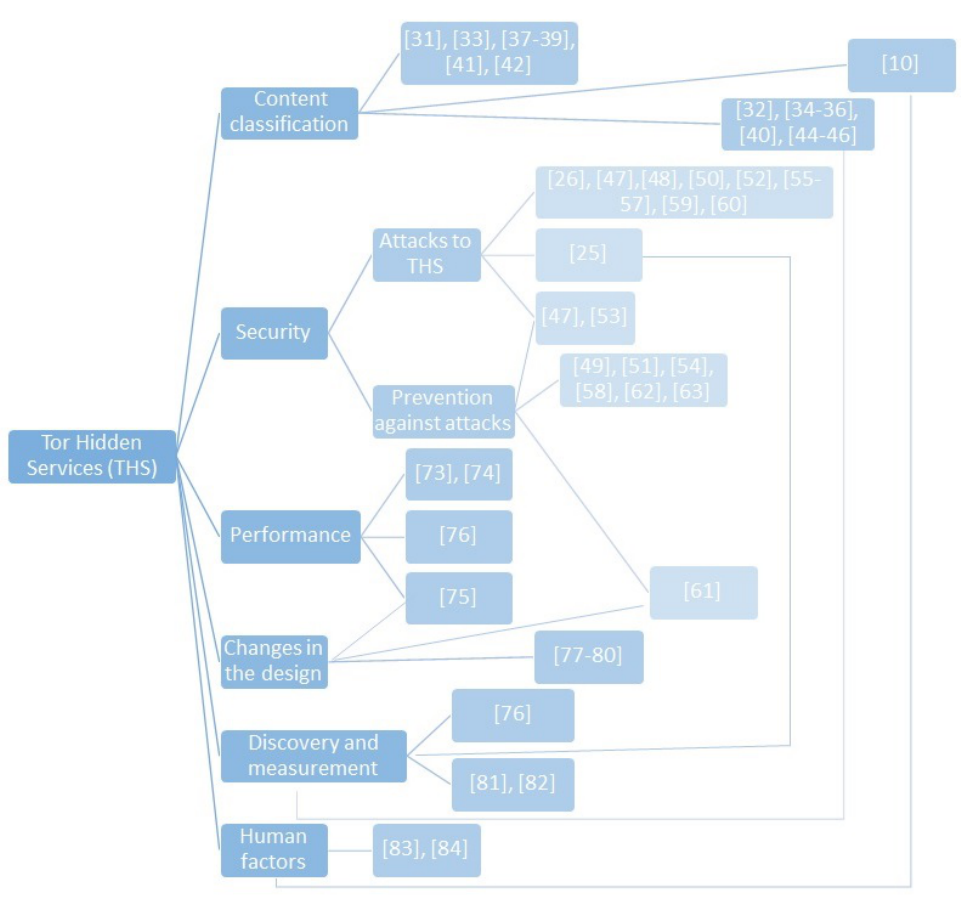
Figure 4. Relationships between papers and